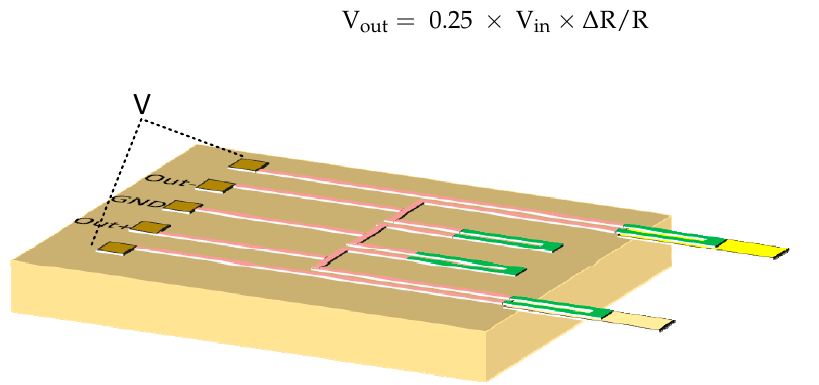
Figure 1. The schematic diagram of the quarter ‐ type wheatstone